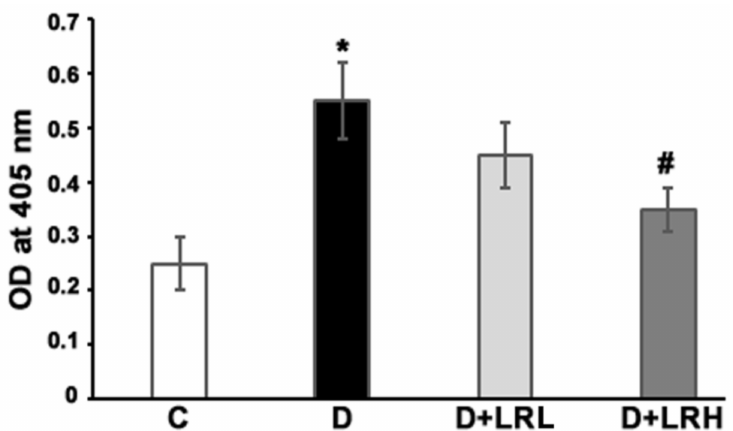
Figure 6. L. regularis inhibits caspase-3 activity in diabetic rat retinas. The activity of caspase-3 was evaluated by colorimetric enzymatic assay in the diabetic rats treated with L. regularis . The results are represented as a fold increase in caspase activity as assessed by an increase in optical density. (* p < 0.01 vs. diabetes; # p < 0.05 vs. control). The values are the means ± SEM (n = 6). Experiments were carried out twice. (LRL, L. regularis low dose; LRH, L. regularis high